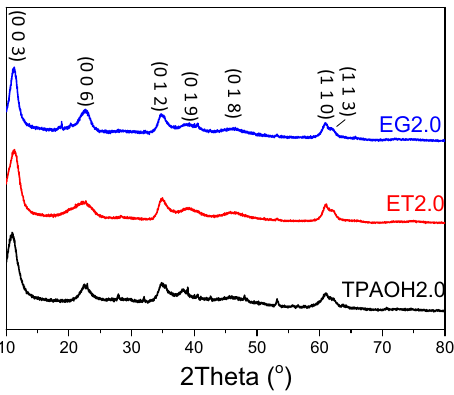
Figure 2: The XRD patterns of EG2.0, ET2.0, and TPAOH2.0.